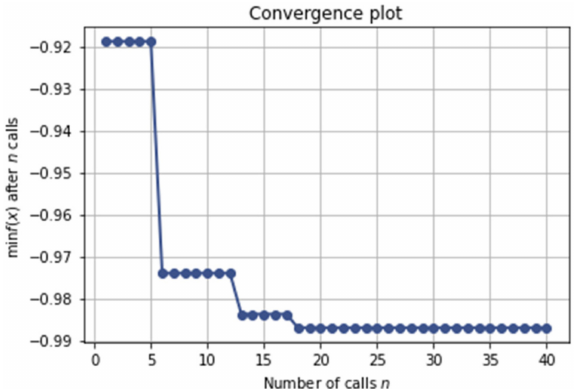
Figure 12. The progress of the hyperparameter